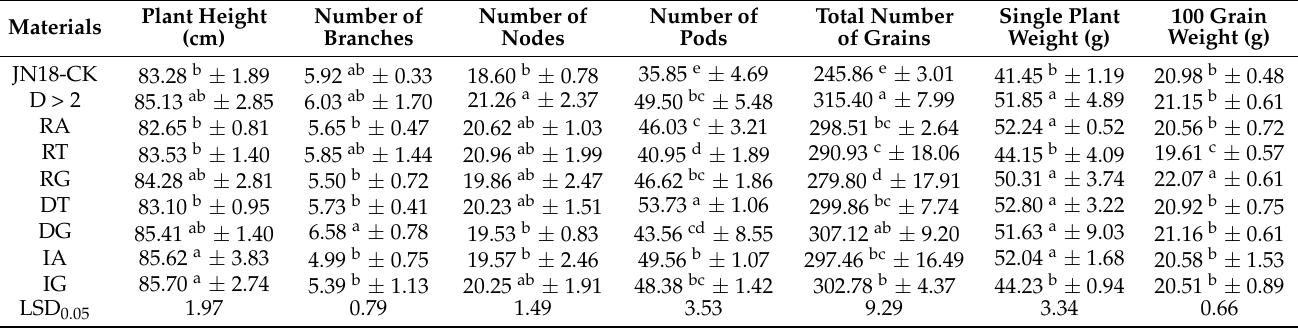
Table 5. Determination of agronomic traits of different edit types in T 2